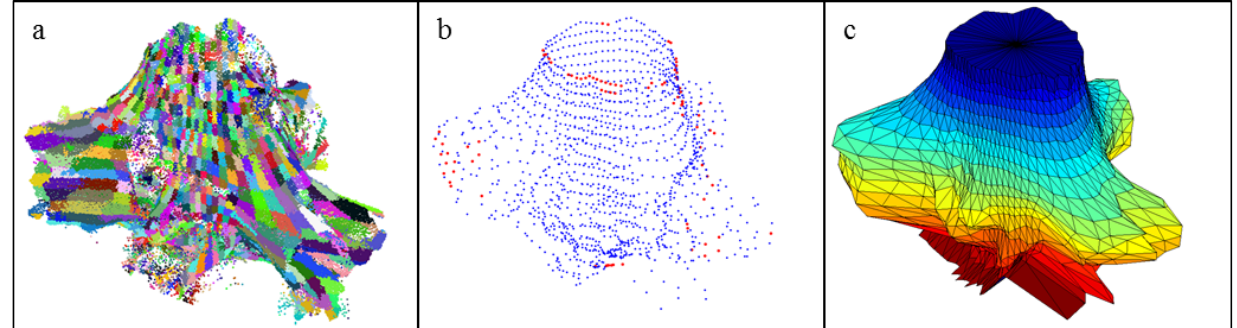
Figure 5. Construction of the closed surface stump model: ( a ) Stump portion partitioned into cells formed by layers and sectors; ( b ) Vertices of the triangles from the partition (blue) and interpolation (red); ( c ) Final closed surface of the cylindrical triangulation